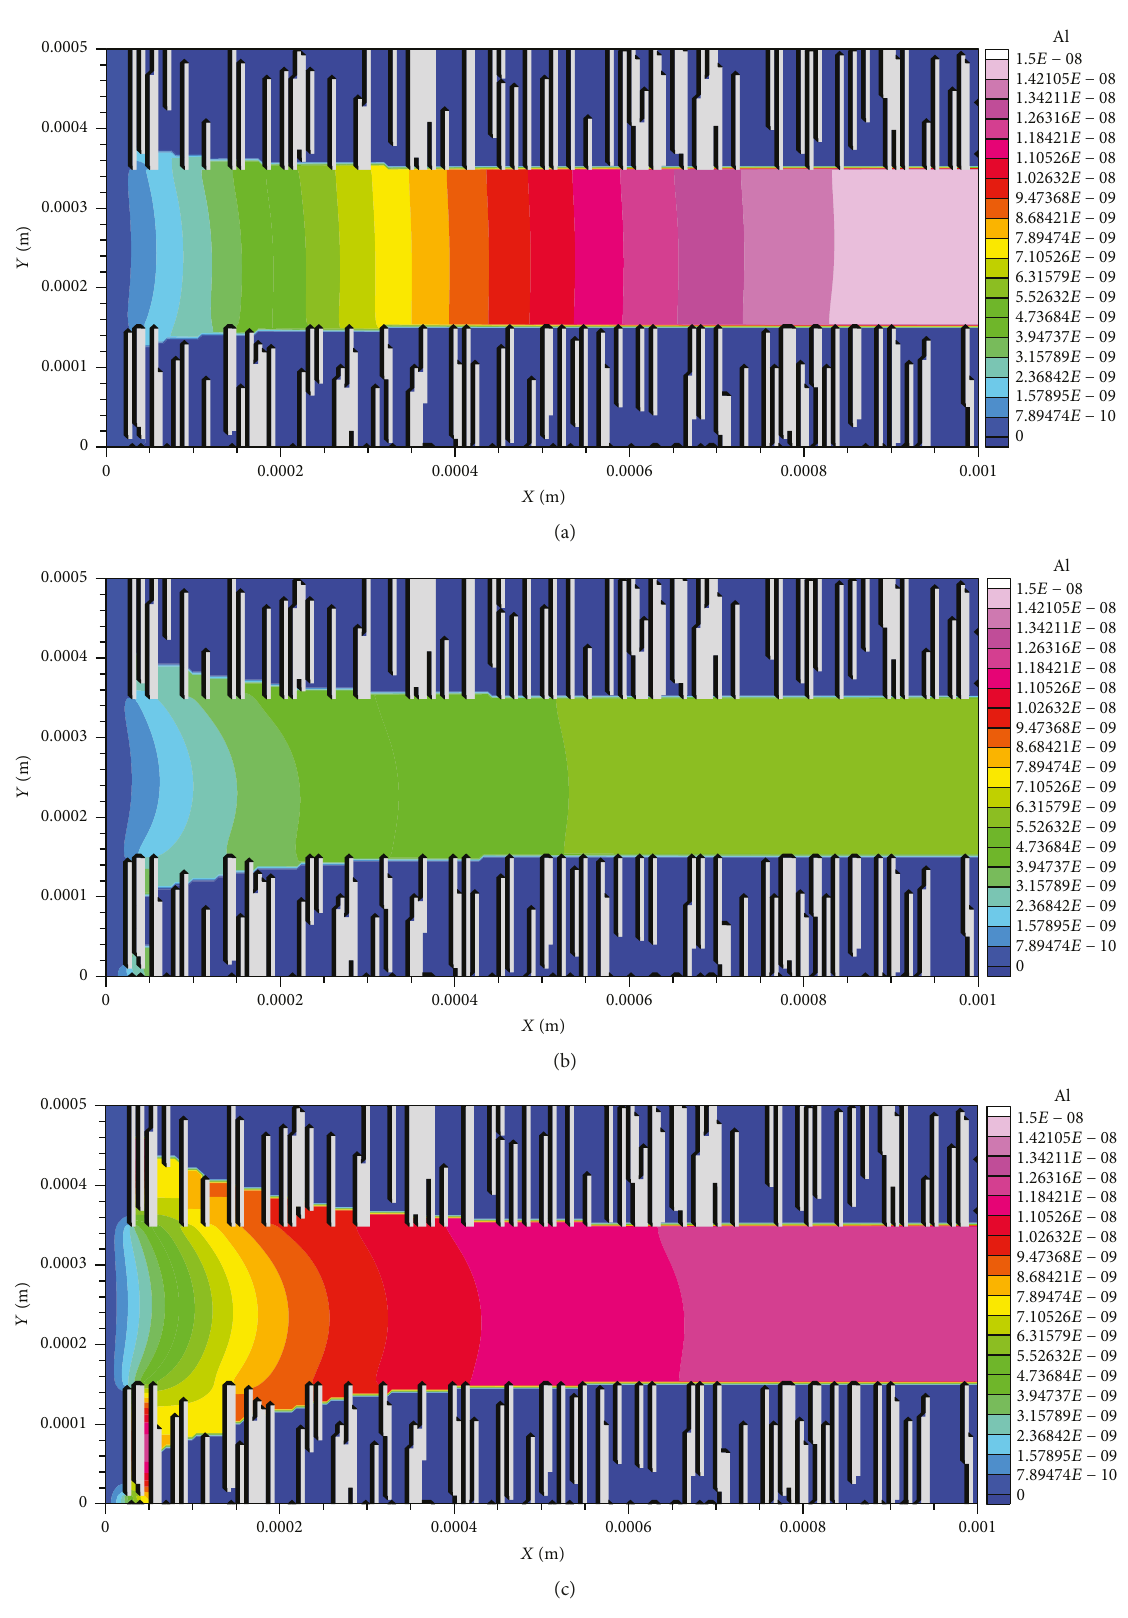
Figure 24: Al concentrations (mol/L) at (a) t = 5 1 hr, (b) t = 12 6 hr, and (c) t = 29 3 hr. In all three cases, Pe=0.026 and kaolinite is illustrated in light